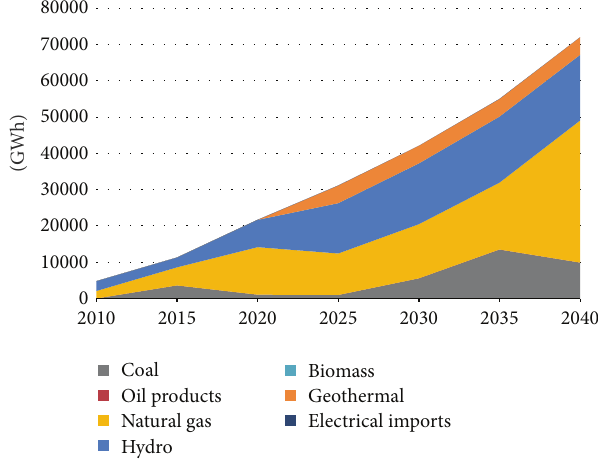
Figure 3: Electricity production by energy source, BAU scenario.